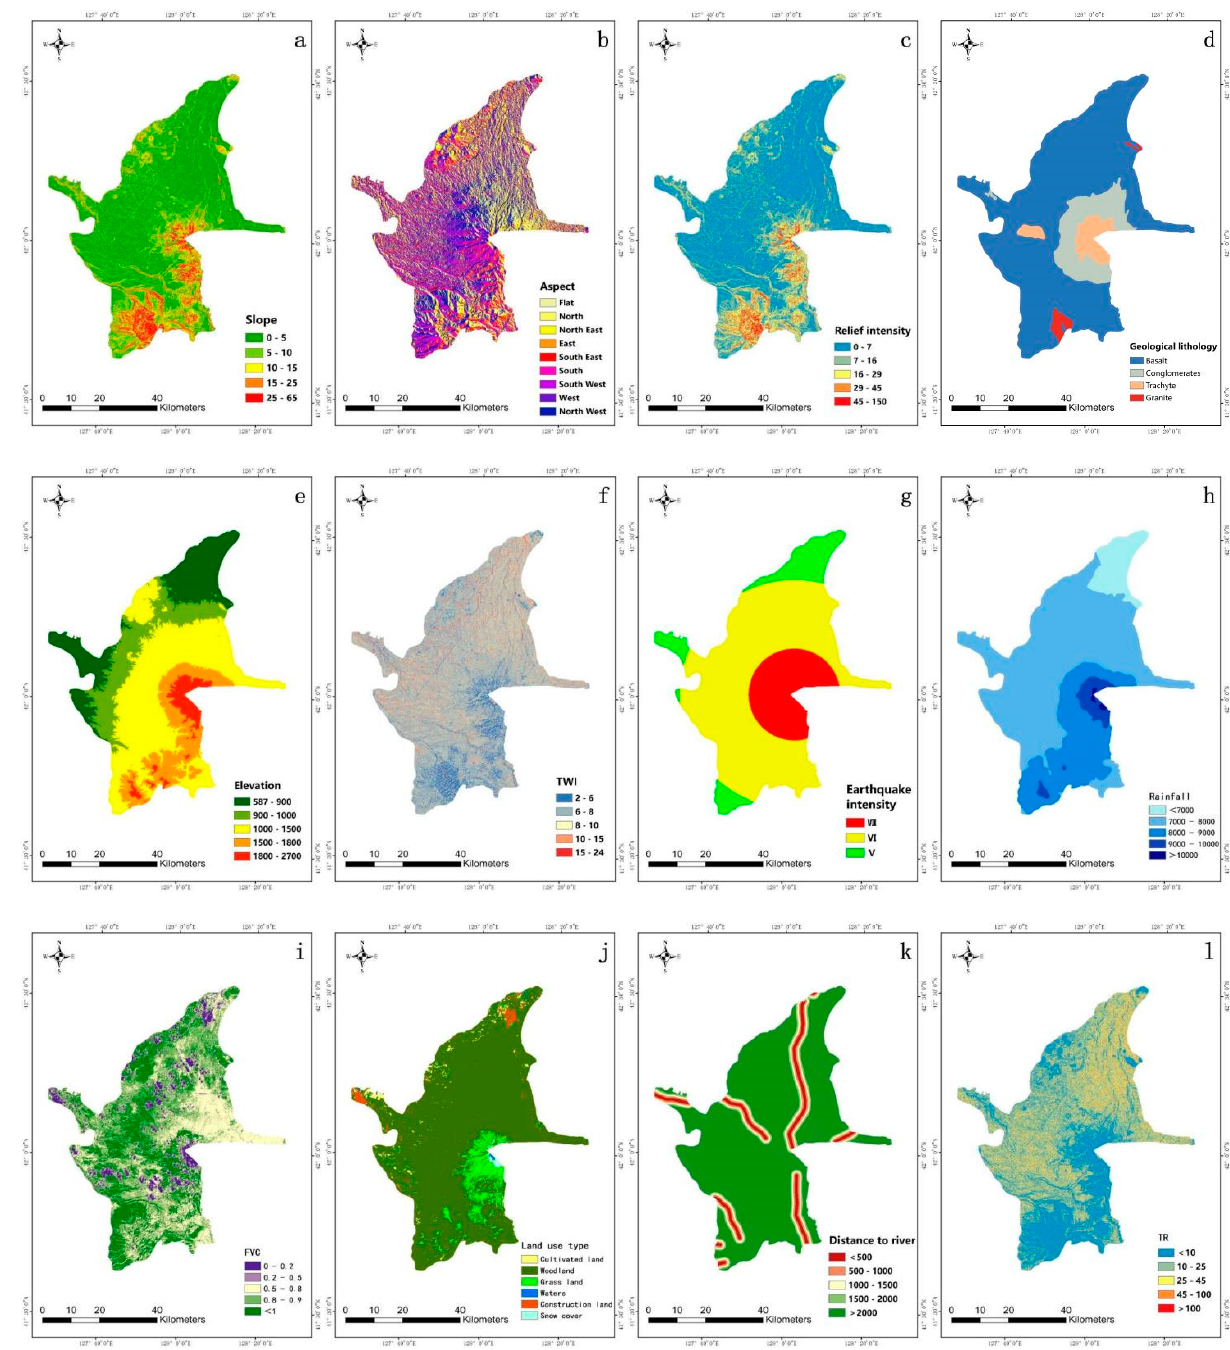
Figure 3. Condition parameters: ( a ) slope, ( b ) aspect, ( c ) relief intensity(RI), ( d ) lithology, ( e ) elevation, ( f ) topographic wetness index (TWI), ( g ) earthquake intensity (EI), ( h ) rainfall, ( i ) fractional vegetation cover (FVC), ( j ) land use type (LUT), ( k ) distance to river (DTR), ( l ) terrain roughness (TR).